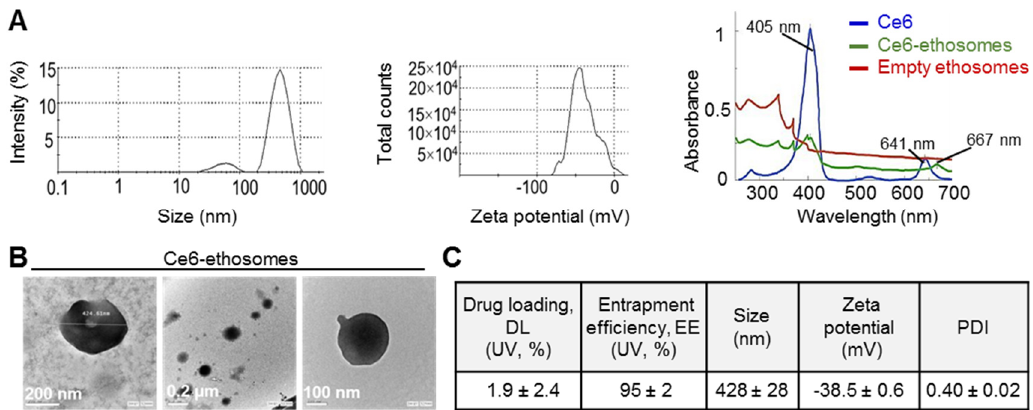
Figure 1. Physicochemical characterization of chlorin e6 (Ce6) ethosomes. ( A ) Mean particle size (left) and zeta potential of Ce6 ethosomes as analyzed by dynamic light scattering and electrophoretic mobility, respectively, in water (0.16 mM). Absorption spectra in water of Ce6 (0.03 mM), Ce6 ethosomes (0.03 mM), and empty ethosomes (15 µg/mL). ( B ) Transmission electron microscope images of Ce6 ethosomes. ( C ) Characterization of Ce6 ethosomes. Drug loading (DL) and entrapment efficiency (EE) were quantified using UV absorption of Ce6; mean particle size, zeta potential, and polydispersity index (PDI) were determined as described in ( A ).